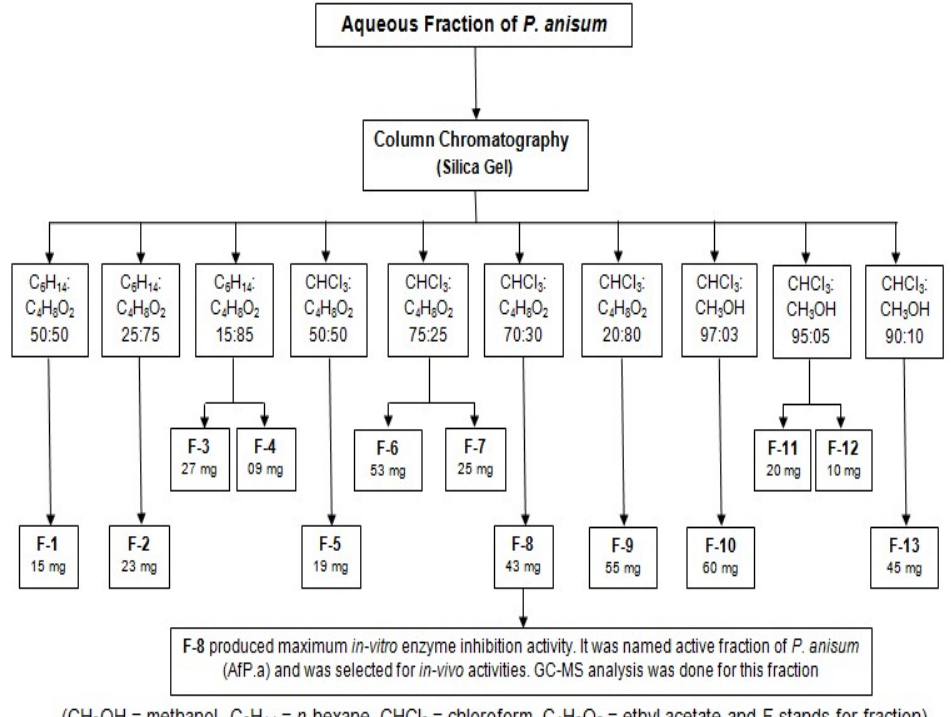
Figure 1. Fractionation of aqueous extract of P. anisum into sub fractions via column chromatography. Table 1. In vitro analysis of the purified fraction of P. anisum for anti-cholinesterase activity.